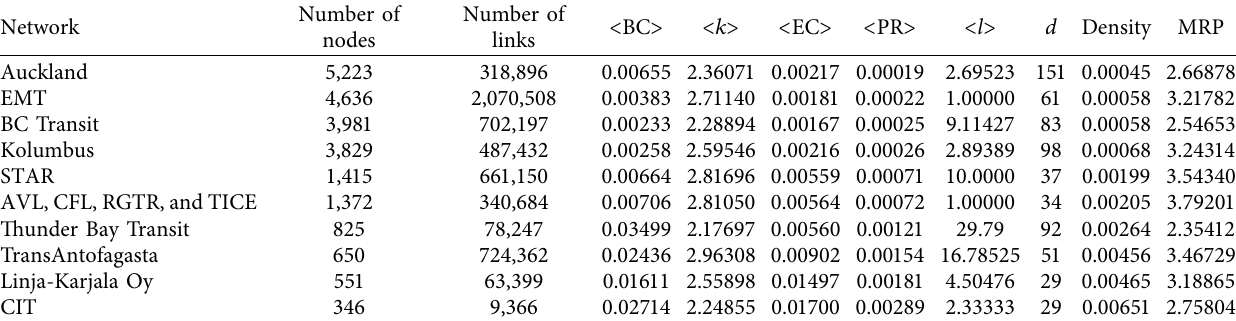
Table 1: Structural properties in L-Space. Average Betweenness Centrality ( < BC > ), average degree ( < k > ), average Eigenvector Centrality ( < EC > ), average PageRank (with a damping factor � 0.85) ( < PR > ), average path Length ( < l > ), diameter ( d ), density, and MRP.